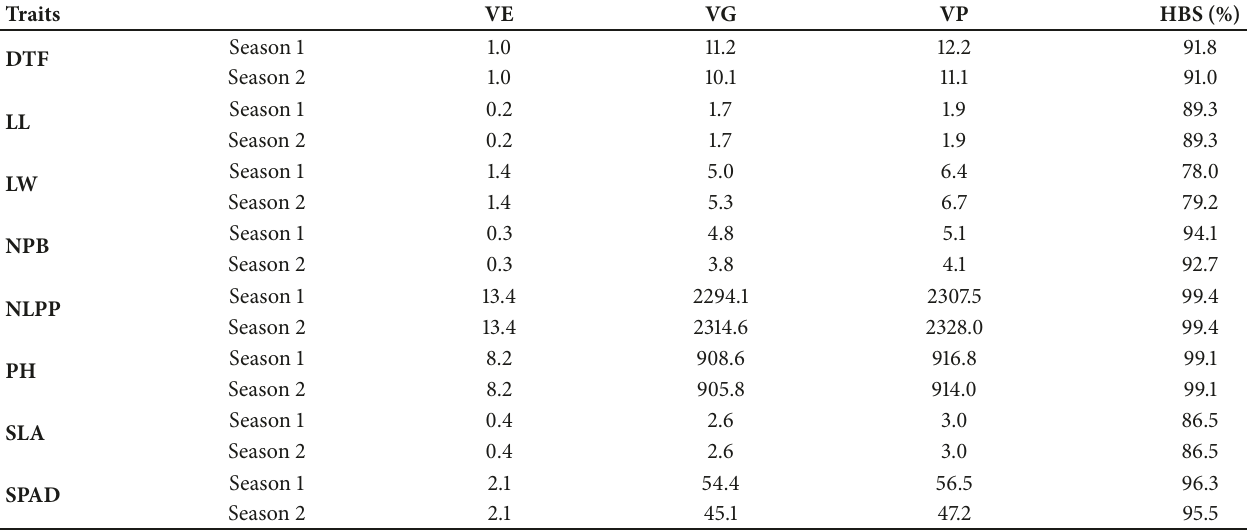
Table 8: Estimates of yield and yield related components of 49 spider plant